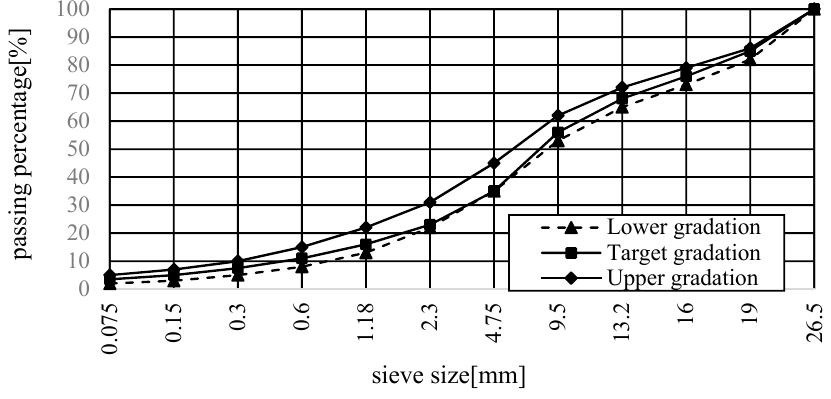
Figure 1. Gradation curve of cement-treated aggregate base material.